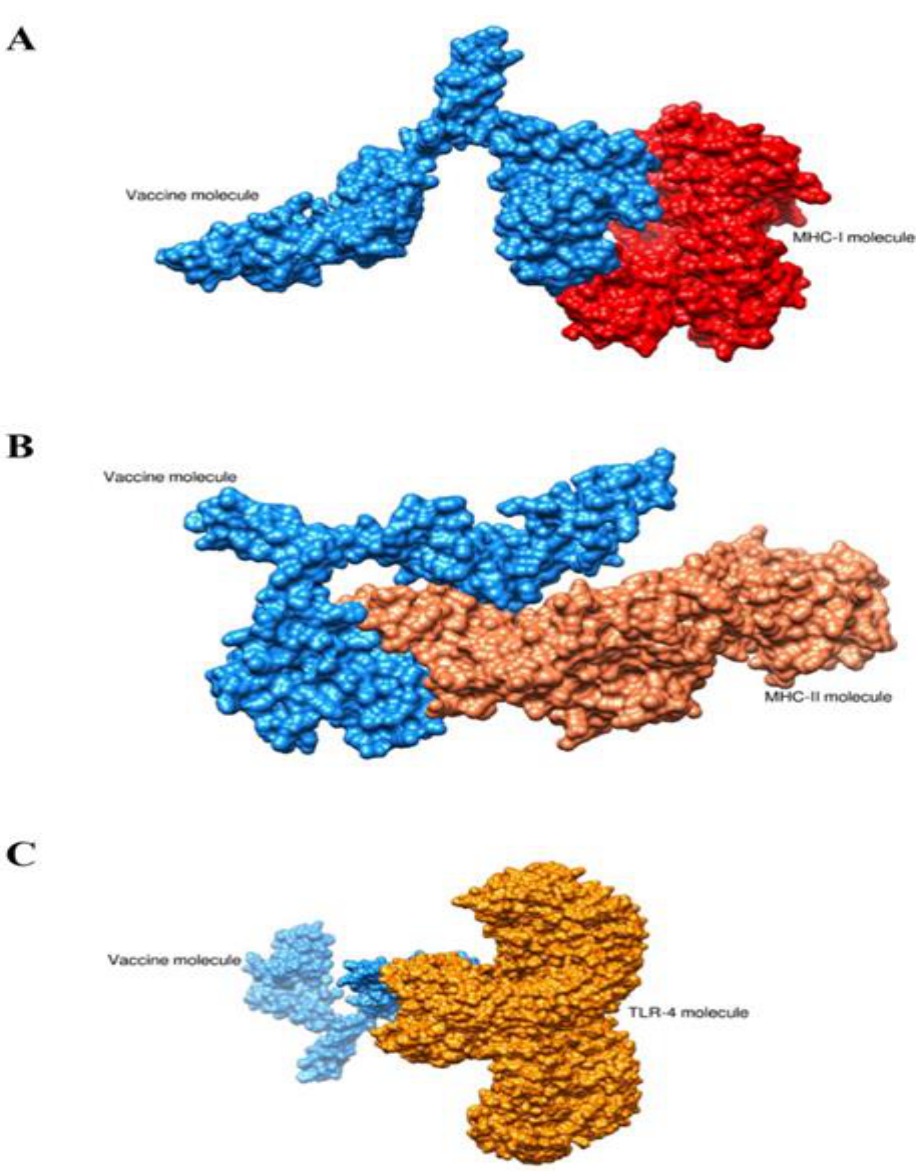
Figure 8. Intermolecular docked conformation of complexes. ( A ) vaccine-MHC-I complex, ( B ) vaccine-MHC-II complex and ( C ) vaccine-TLR-4 complex.